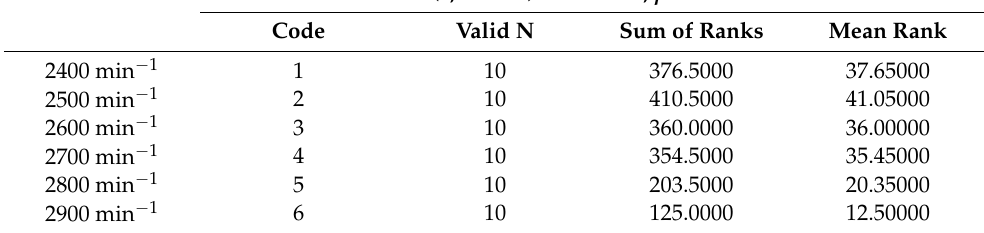
Table 4. Comparison table of the model for analyzing the dependence of the number of holes drilled up to the moment of tool damage and speed.